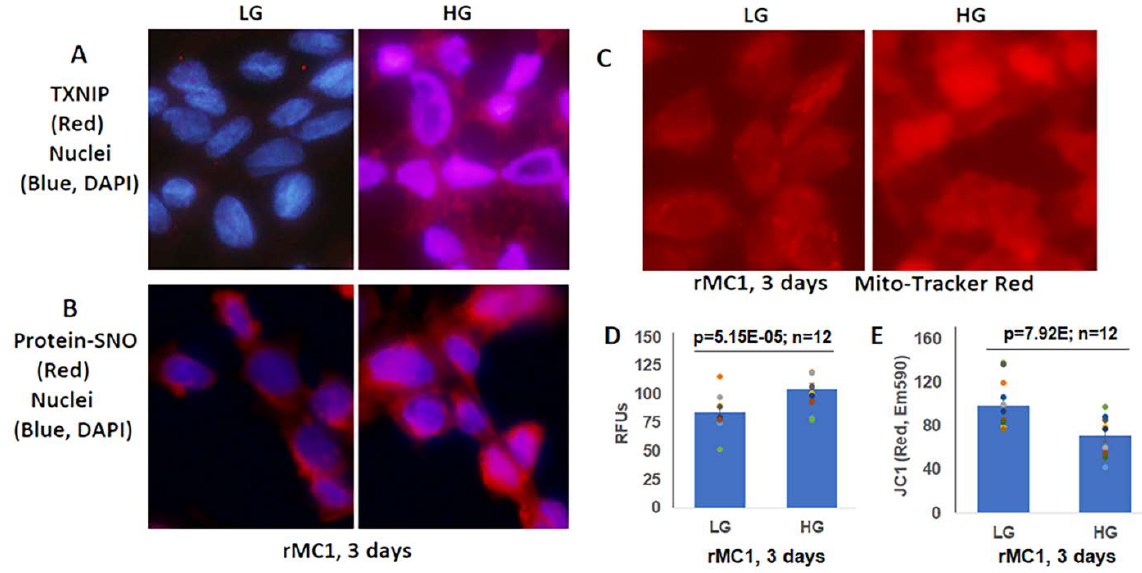
Figure 3. High glucose induces TXNIP expression and redox stress in rMC1 in in vitro culture. ( A ) HG exposure of rMC1 cells for 3 days increases TXNIP expression and ( B ) protein s-nitrosylation (SNO), suggesting cellular oxidative/nitrosative stress when compared to LG. DAPI was used to counter stain the nuclei (blue). ( C , D ) Similarly, mito-tracker red staining (EX579/Em599) and mitoSox fluorescence intensity (EX510/Em580) are also enhanced, indicating mitochondrial stress and damage. ( E ) In agreement, mitochondrial membrane potential is disturbed/depolarized (reduced red of JC-1 aggregates, EX535/Em590) in rMC1 under HG versus LG. The immunofluorescence images represent n = 3, captured by an Olympus BX51 fluorescence microscope at 400× magnification.